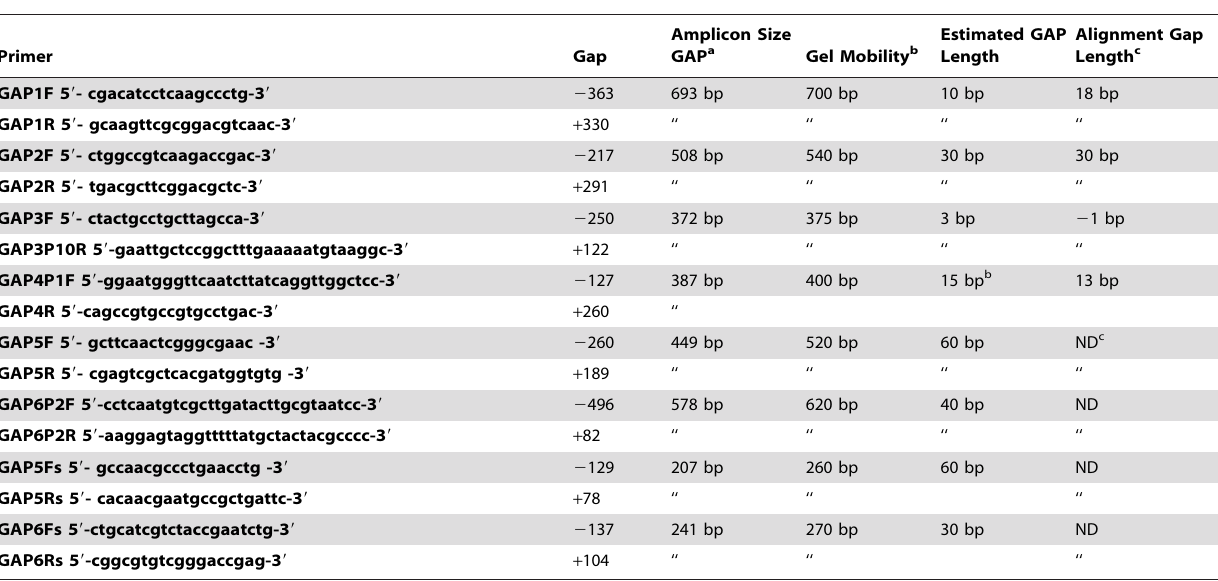
Table 1. Amplification/Sequencing Primers and Amplicon Electrophoretic Mobility Evaluation.